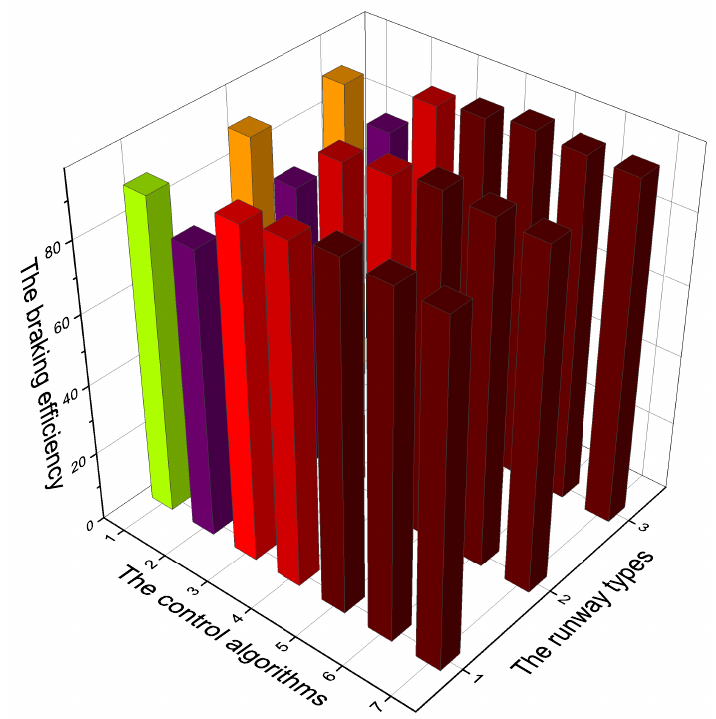
Figure 13. The average slip rate efficiency of seven algorithms under three runway conditions. Each value interval is represented by different colors, such as purple for data between 70 and 75, red for data between 75 and 80, red and black for data between 80 and 85, brown and Green represents more than 85 of the data, where green represents slightly higher data than brown.